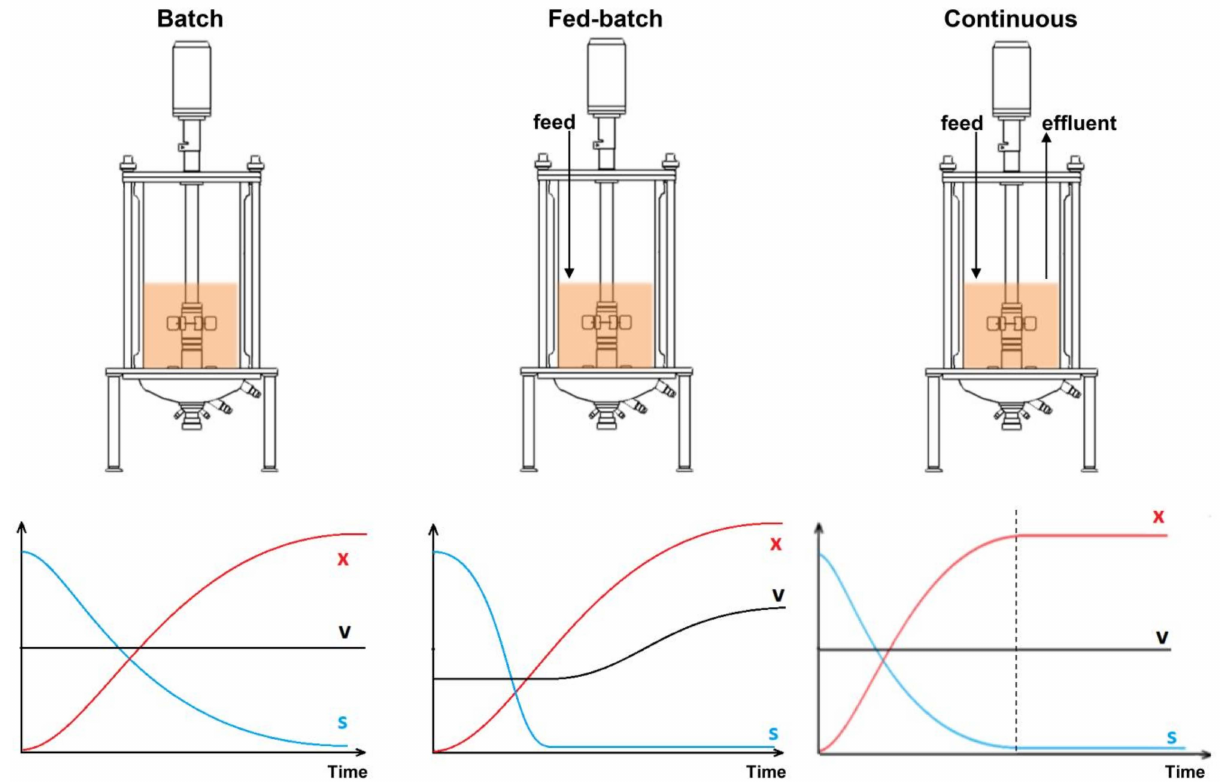
Figure 1. Modes of operation for cell cultivation. X—biomass, V—volume, S—substrate concentration. Vertical dashed line indicates the onset of the continuous process, as usually it starts with a batch or a fed-batch